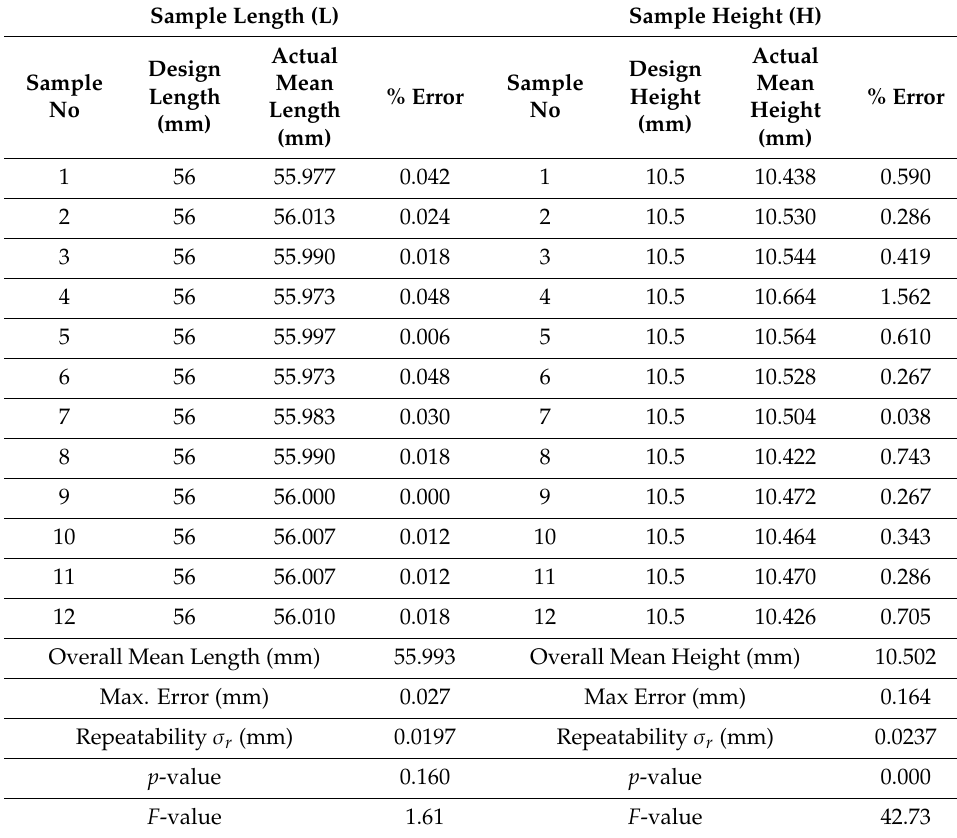
Table 1. Measurement and ANOVA results of the samples (set 1) under repeatability